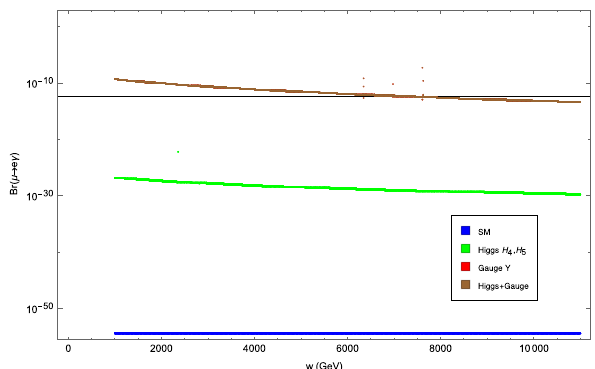
Fig. 6 The figure presents the dependence of the branching ratio Br (μ → e γ) on the NP scale w for each contribution. The solid black line indicates the upper from the experiment [40]. Here u = 10